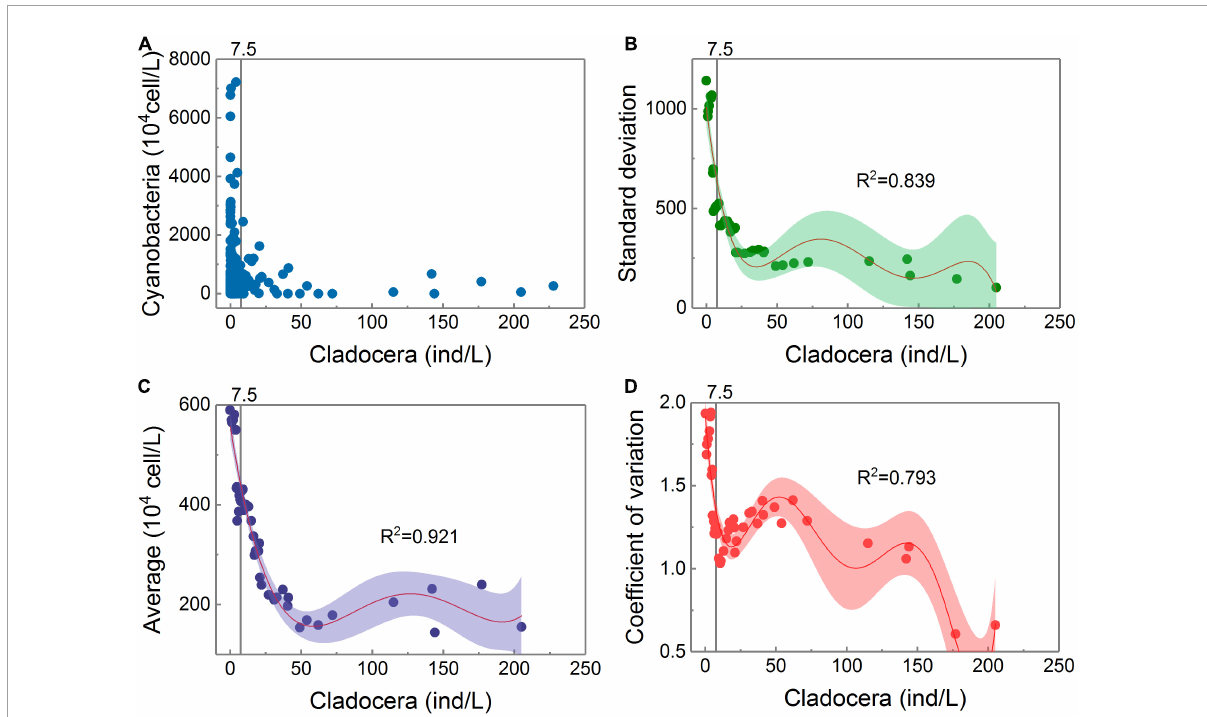
FIGURE4 Panel (A) shows the scatter points of the Cladocera Density-Cyanobacteria Density. The trends of the dispersion degrees of the scatter points with changes in cladocera density. Panels (B–D) all adopt the polynomial fitting method, while panel (B) uses a 5th degree polynomial, panel (C) uses a 4th degree polynomial, and panel (D) uses a 6th degree polynomial. There is only one sample on the right side of the abscissa to 206 ind/L, and calculations of the average, standard deviation, and coefficient of variation are not